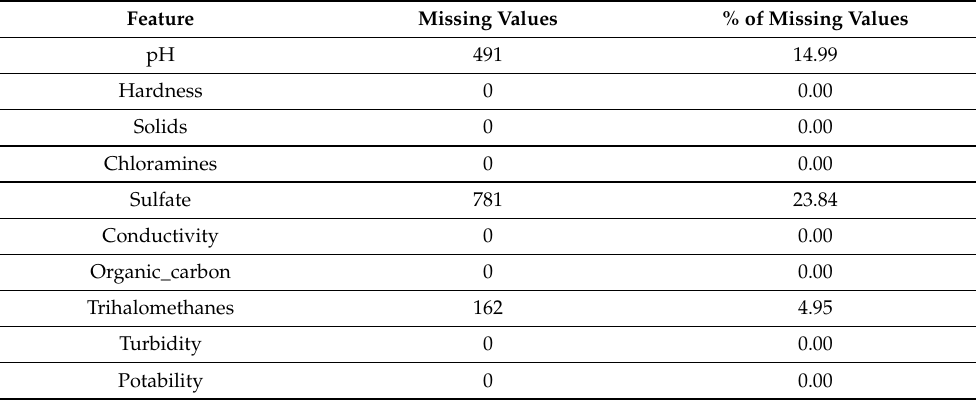
Table 3. Missing values in the